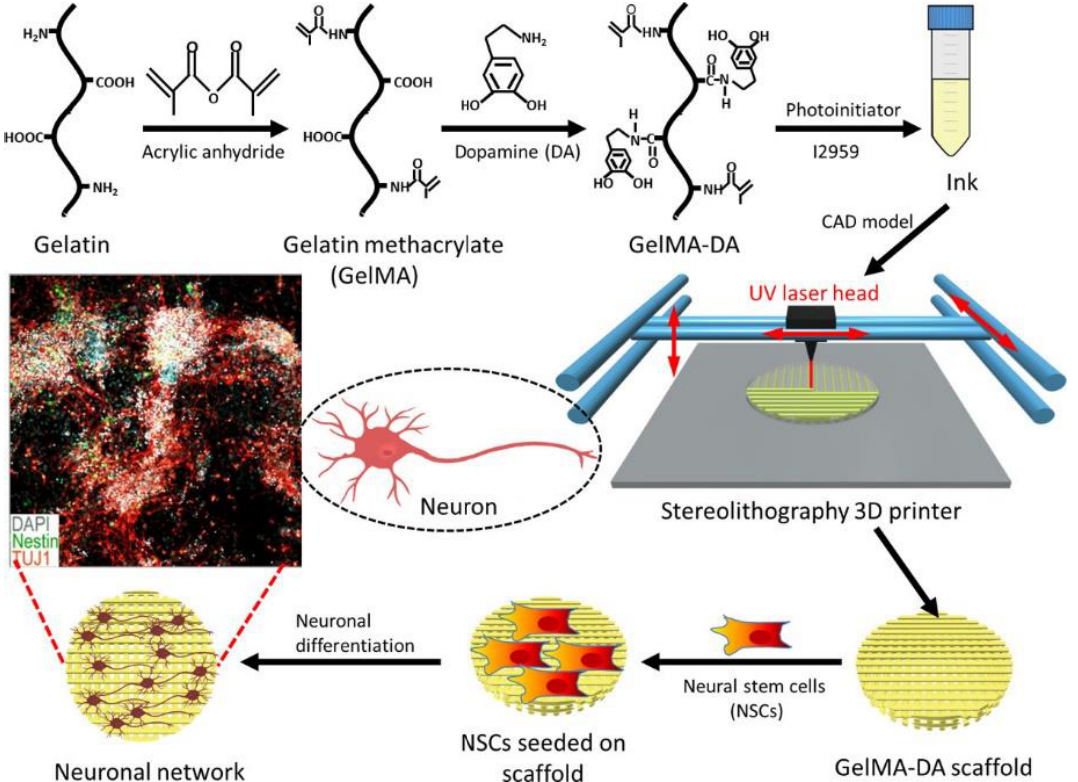
Figure 5. Schematic of a 3D bioprinted matrix utilized to promote neural cell support for tissue regeneration. Reprinted with permission from [134] .